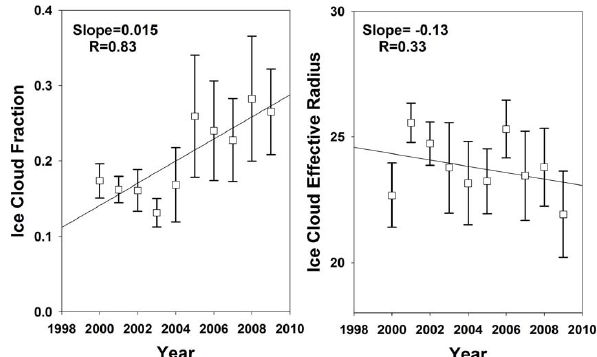
Figure 5 The trend of ice cloud fraction and ice cloud effective radius over India-Myanmar region.